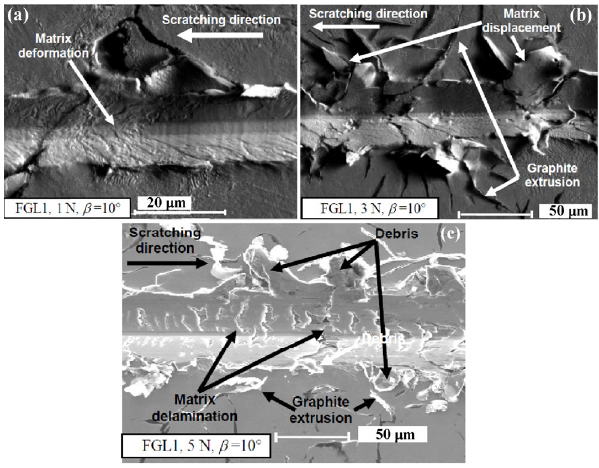
Fig. 7 Pearlite matrix deformation and formation of debris, FGL1 iron, indenter apex angle 2  = 160° (attack angle,  = 10°), F n = 1, 3, and 5 N.